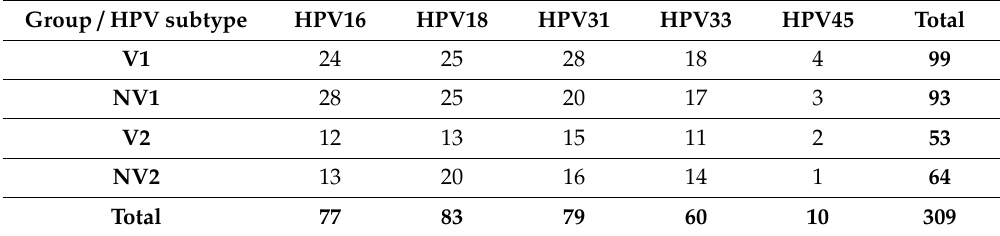
Table 1. Distribution of the participating women according to HPV infection subtype across the study groups. V1: vaccinated women with HPV DNA-positive and mRNA-negative results, NV1: non-vaccinated women with HPV DNA-positive and mRNA-negative results, V2: vaccinated women with HPV DNA- and mRNA-positive results, NV2: non-vaccinated women with HPV DNA- and mRNA-positive